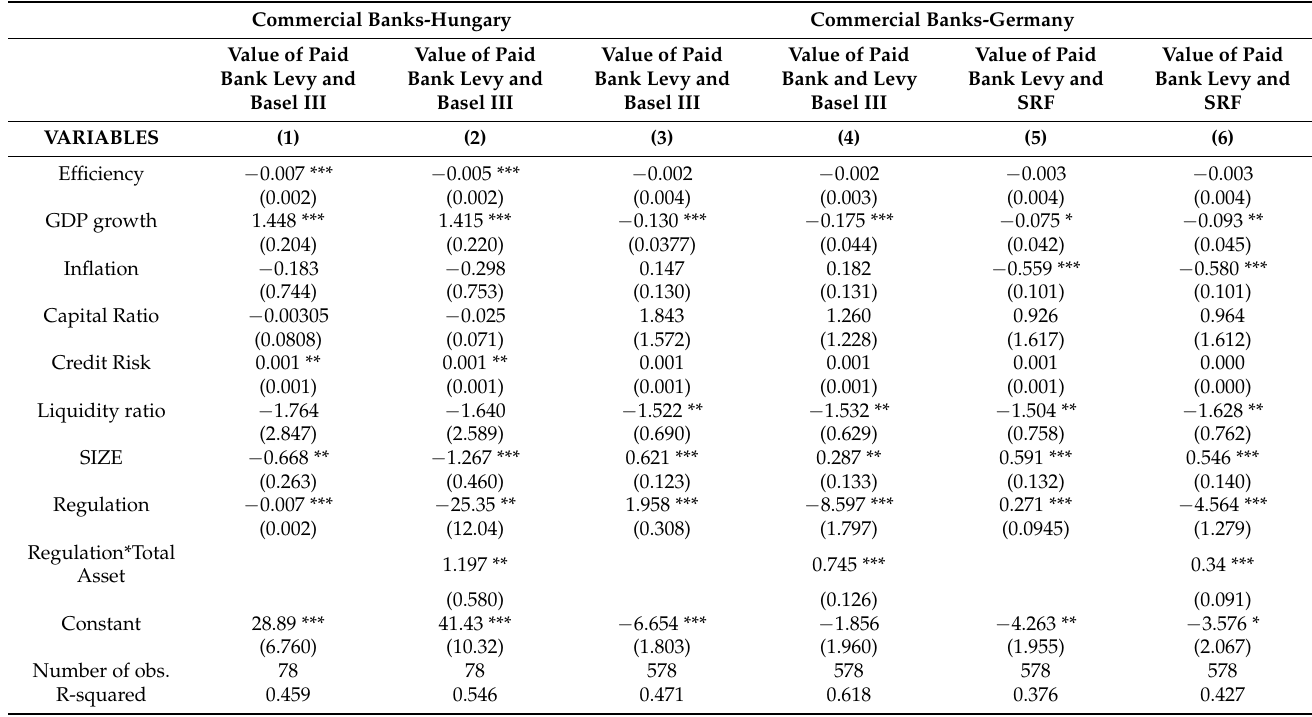
Table 10. Have other financial market regulations affected the amount of bank levy. The Hungarian and German experience. Symbols *, **, and *** represent statistical significance at the levels of 10%, 5%, and 1%,